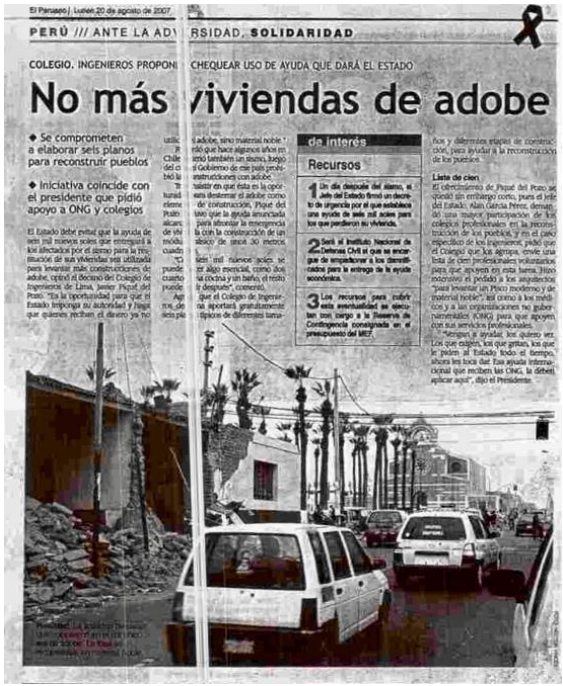
Figure 3. Announcement in El Peruano, August